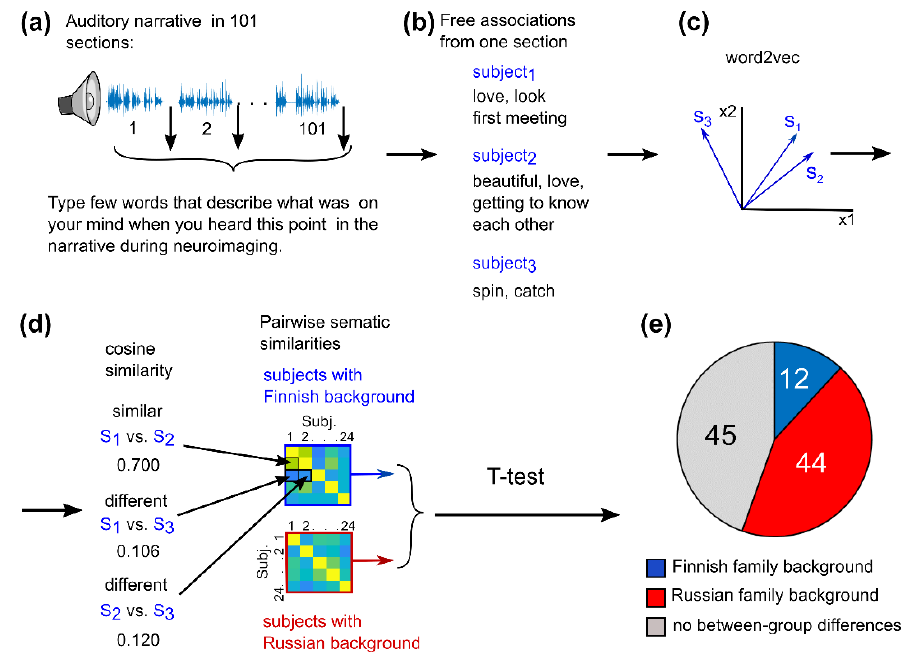
Figure 3. Schematic illustration and results of the behavioral free association task. ( a ) In the free association task, the audiobook was presented to the participant in 101 segments after the fMRI session. ( b ) After each segment, the participant typed in 20–30 s words that described what was on his/her mind at that point of the audiobook during fMRI. ( c ) The associated words were transformed into 500-dimensional vector representations in a semantic space (word2vec). For each segment, a vector sum was calculated over the vector representations of the words the participant had